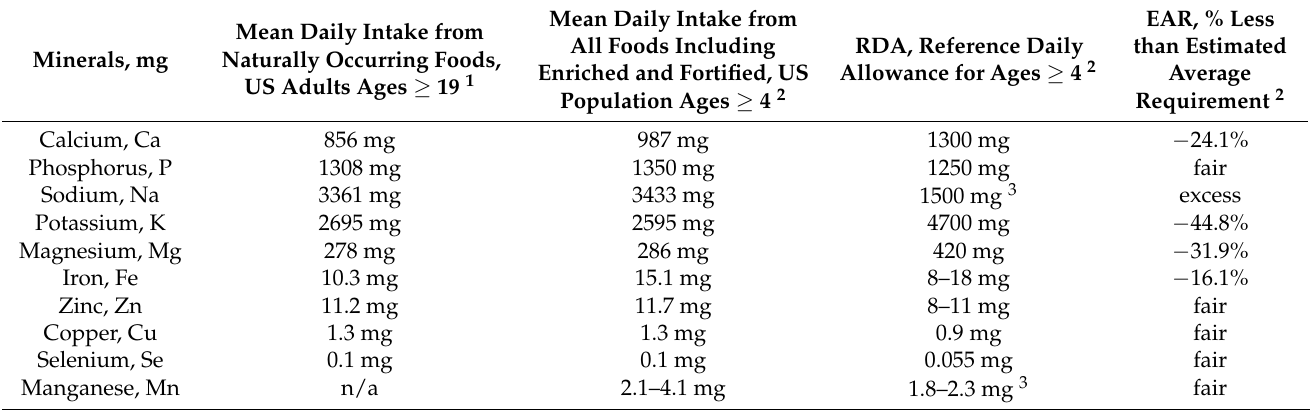
Table 1. Selected mineral intakes and inadequacies in the US population. Primary mineral inadequa- cies (shortfall micronutrients) are highlighted in